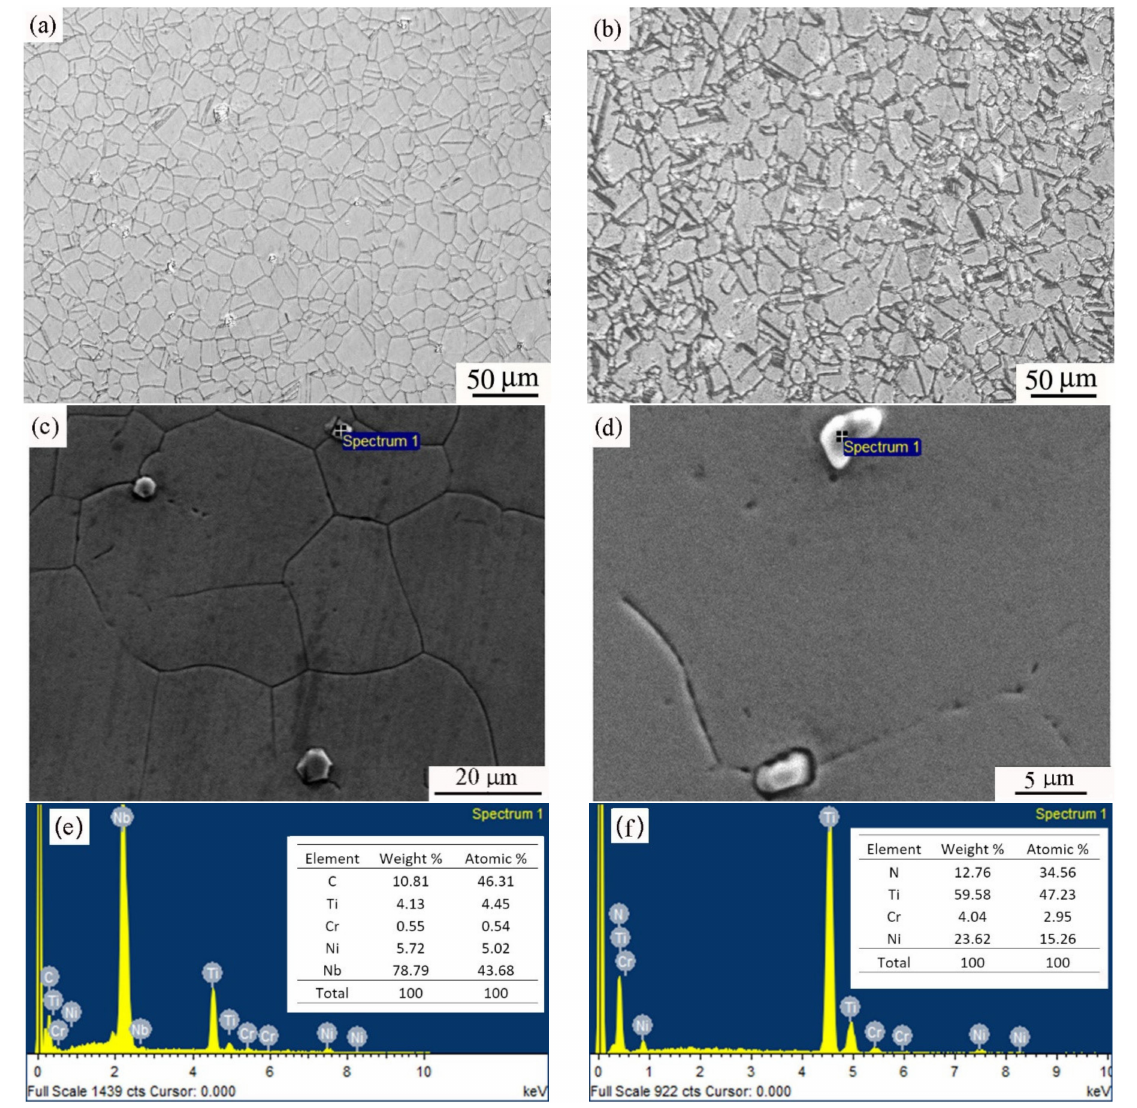
Figure 1. Optical and scanning electron micrographs of Inconel 718 ( a , c ) and Inconel 600 ( b , d ). ( e , f ) show EDS spectra obtained from second phase particles present in Inconel 718 and Inconel 600,